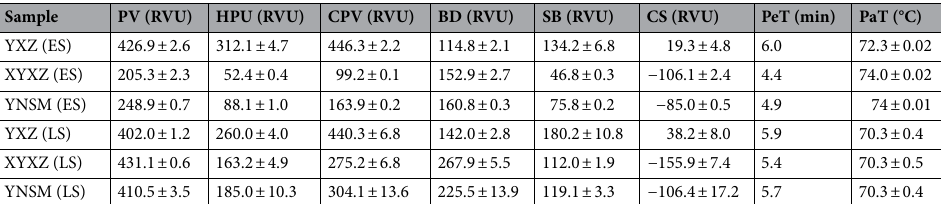
Table 2. Starch-related physicochemical properties of the rice varieties used in this research. ES early season; LS late season.